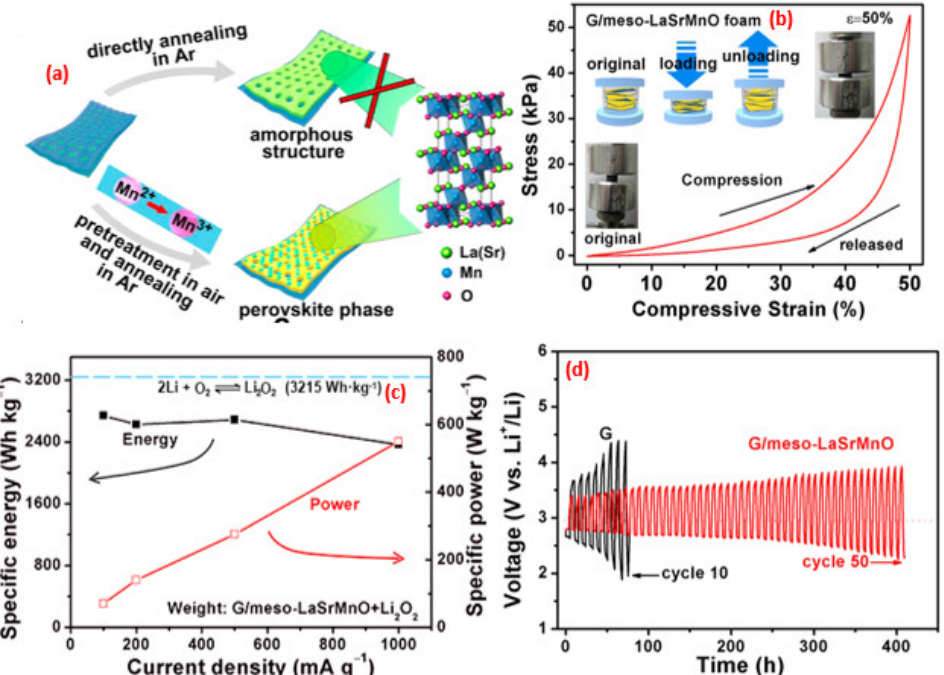
Figure 9. ( a ) Schematic illustration of the formation process of perovskite structure under different reaction conditions. ( b )G/meso-LaSrMnO foam at a specific strain of 50%. The inset shows the structural model of the meso-LaSrMnO monolith and G/meso-LaSrMnO foam. ( c ) The specific energy and power of the Li-O 2 cell with a G/meso-LaSrMnO electrode. ( d ) Voltage versus time graph of G and G/meso-LaSrMnO electrode at a discharge limit of500 mAh · g − 1 . Copyright 2016 by the American Chemical Society [110].